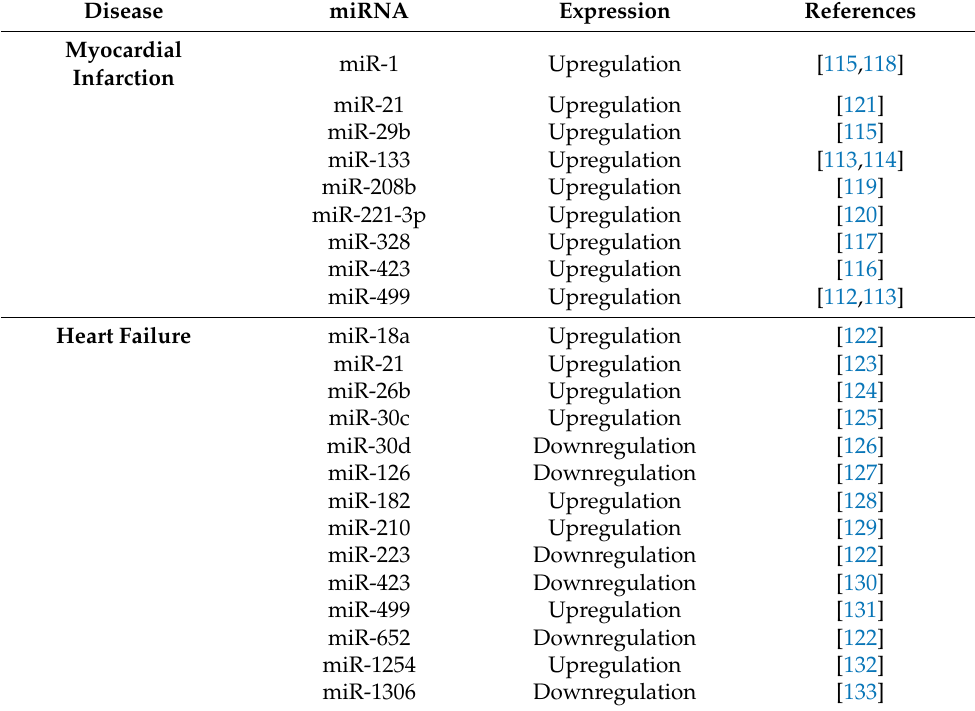
Table 2. Diagnostic relevance of miRNA in acute myocardial infarction and heart failure.